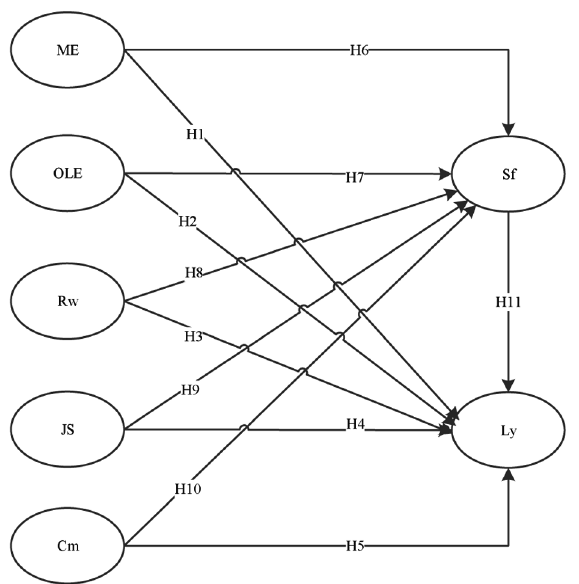
Fig. 1. Initial theoretical